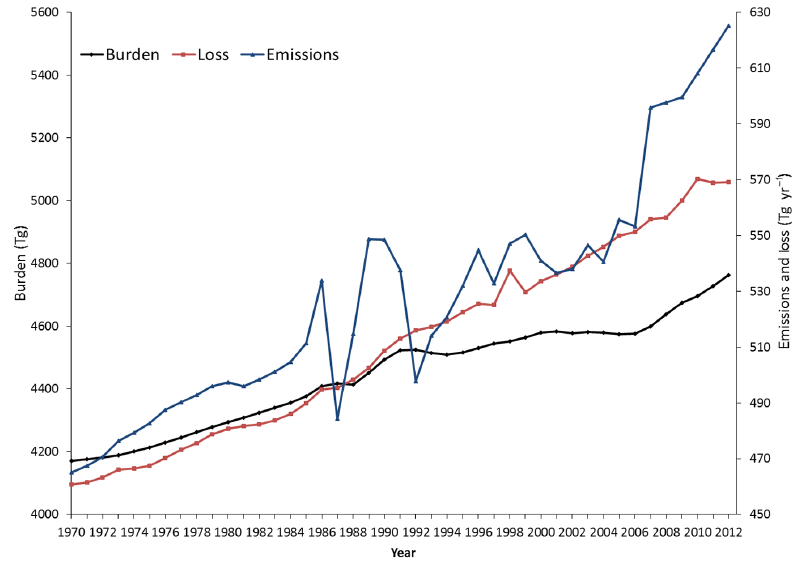
Figure 2. Global CH 4 budget in the main Oslo CTM3 simulation over the period 1970–2012: atmospheric burden (left y axis); loss: atmo- spheric chemical destruction + soil uptake (right y axis); and total emissions (right y axis). Table 1. Overview of simulations performed with the Oslo CTM3